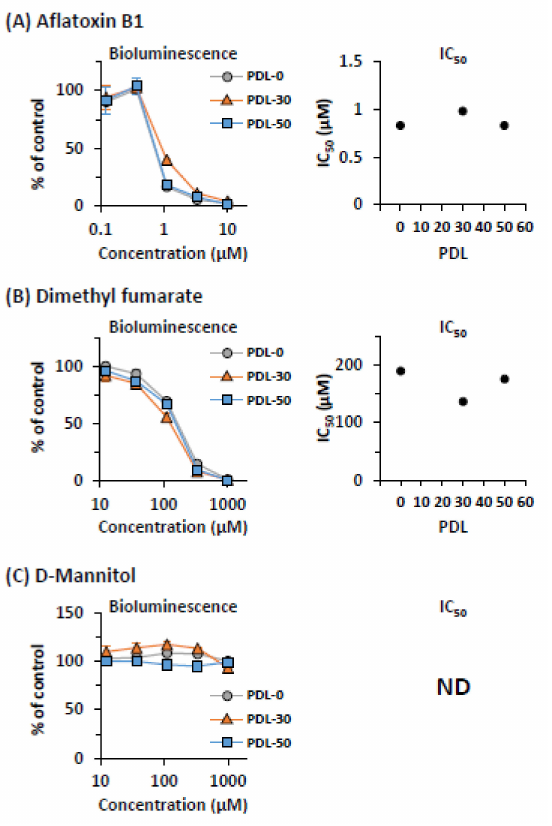
Figure 4. Stability of effects of aflatoxin, dimethyl fumarate, and D-mannitol on bioluminescence intensity in CYPs-ELuc-HepG2 cells during long-term culture. CYPs-ELuc-HepG2 cells at PDL- 0, − 30, and − 50 were treated with aflatoxin B1 ( A ), dimethyl fumarate ( B ), and D-mannitol ( C ). Bioluminescence intensity was measured non-destructively for 5 s (left panels). Data are expressed as percentage of vehicle control cells (set at 100%) and shown as means ± standard deviations ( n = 3). IC 50 value at each PDL was calculated from the concentration-response curve obtained by bioluminescence measurement (right